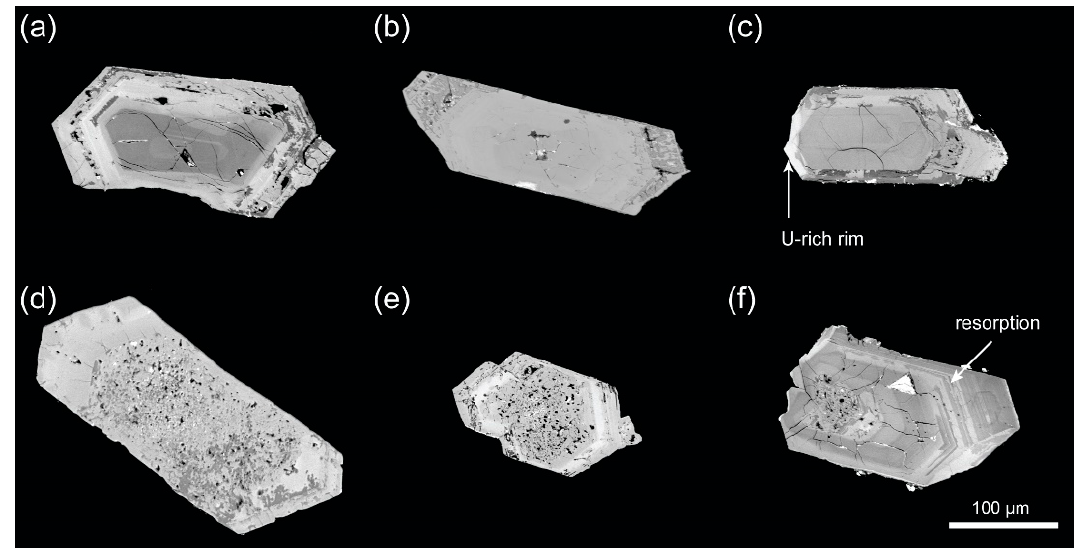
Figure 6. Representative BEC images of analyzed zircons by Lee et al. [25]. ( a , d ), ( b , e ), and ( c , f ) belong to samples P001, P002, and P006, respectively. Zircons separated from the three rock samples can be grouped type 1 ( a – c ) and type 2 ( d – f ) based on chemical composition and internal